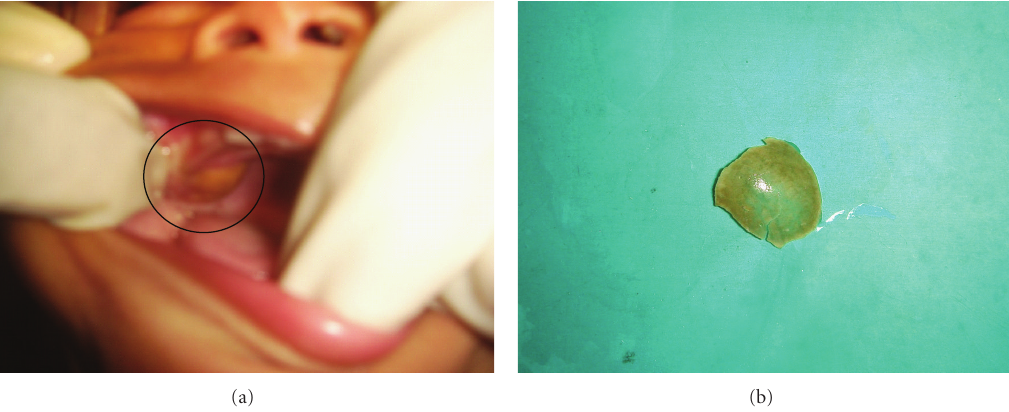
Figure 3: (a) Suspected neuroectodermal tumour of infancy. (b) Peel of a jackfruit seed that caused the illusion. General dentists misdiagnosed 45.9%, oral and maxillofacial surgeons 42.8%, endodontists 42.2%, and periodontists 41.2% of the time. The most commonly missed clinical diagnoses were hyperkeratosis (16%), focal inflammatory fibrous hyperplasia (10%), fibroma (8%), periapical granu- loma (7%), and radicular cyst (6%). Cancerous lesions were misdiagnosed 5.6% of the time